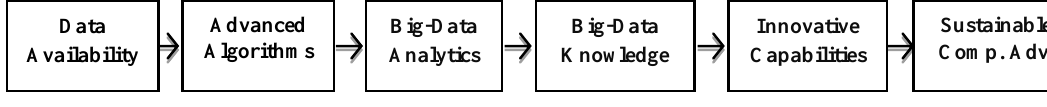
Figure.1. Theoretical